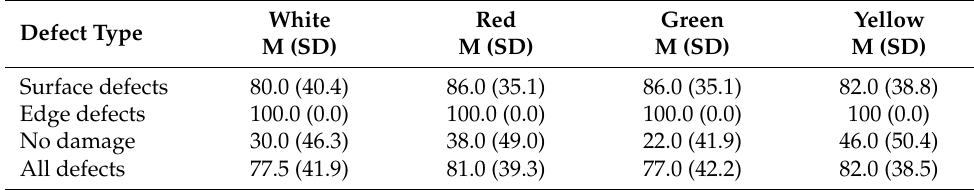
Table 6. Inspection accuracies by defect type and severity (in percentages).